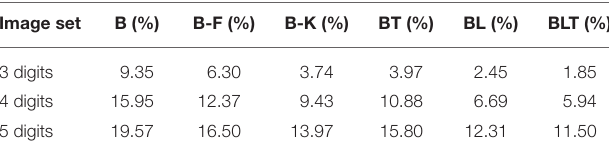
TABLE 5 | Classification error for all of the models on MNIST with varying levels of Gaussian noise. Image